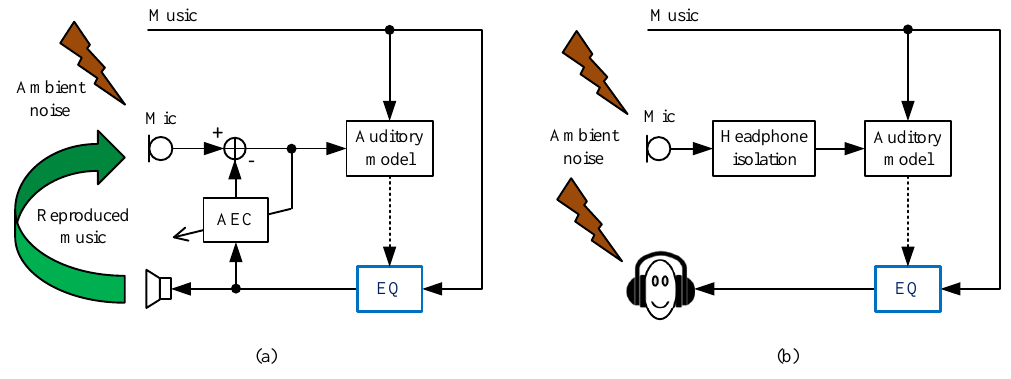
Figure 17. Block diagrams of noise-based equalization for ( a ) loudspeaker [217] and ( b ) headphone reproduction [206,220]. The dashed line indicates that the auditory model controls the parameters of the